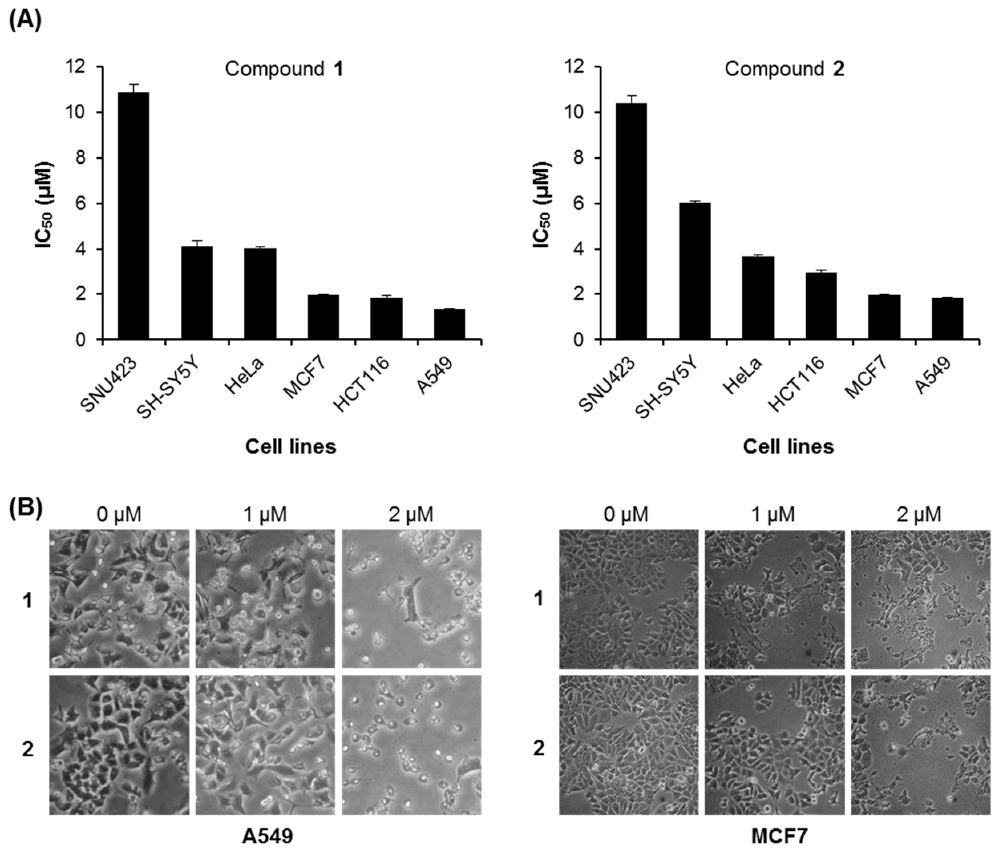
Figure 4. IC 50 values of compounds 1 and 2 against human cancer cell lines. ( A ) The IC 50 values of compounds 1 and 2 for indicated cell lines; ( B ) Cell morphology of A549 and MCF7 cells treated with compounds 1 and 2 for 24 h under microscopic observation (400×).